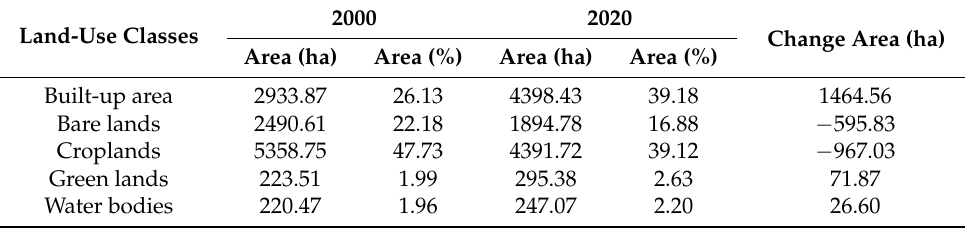
Figure 5. Ardabil city expansion over 20 years (2000–2020). Table 3. Area of land cover classes and their percentage change during studied time periods.